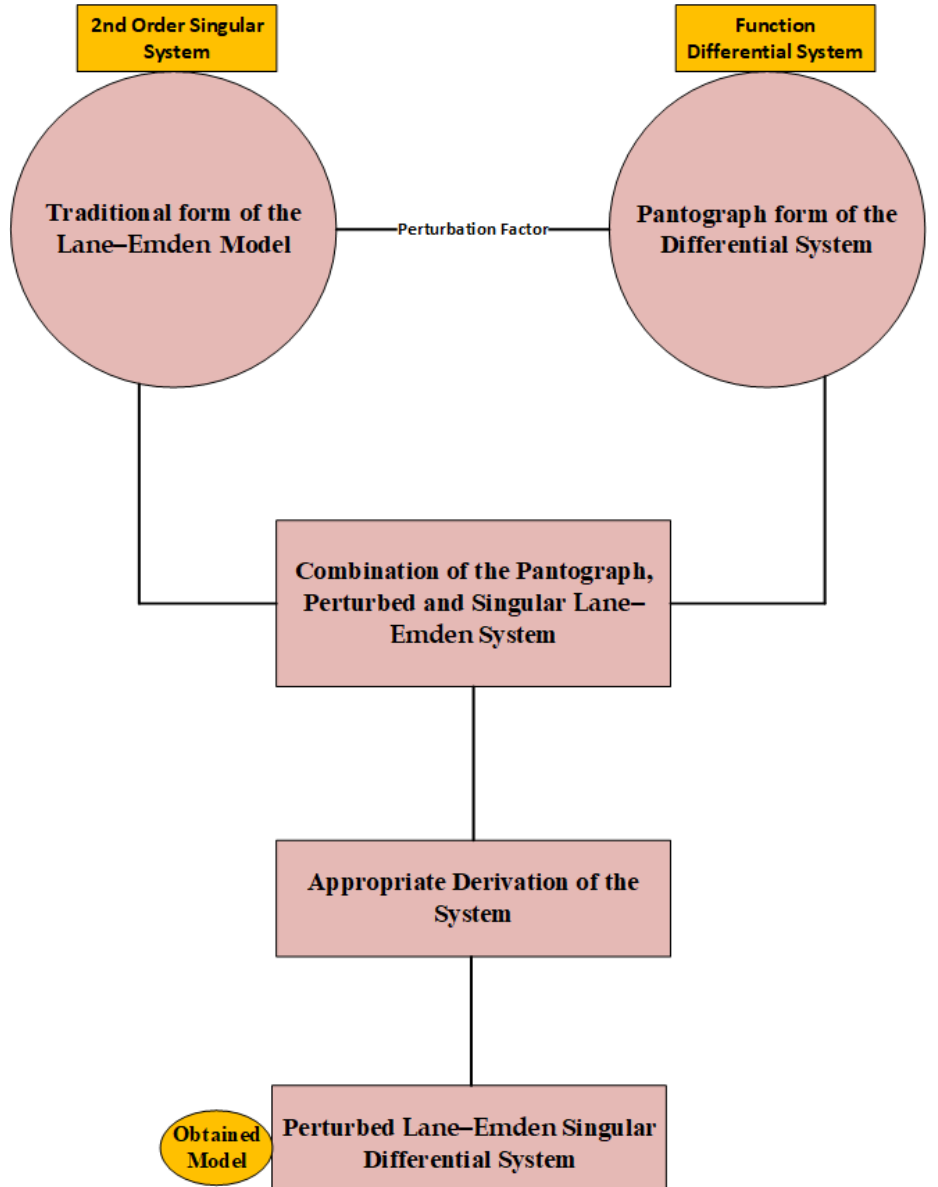
Figure 1. Flow-chart descriptions to achieve the mathematical form of the NSPM-SK.